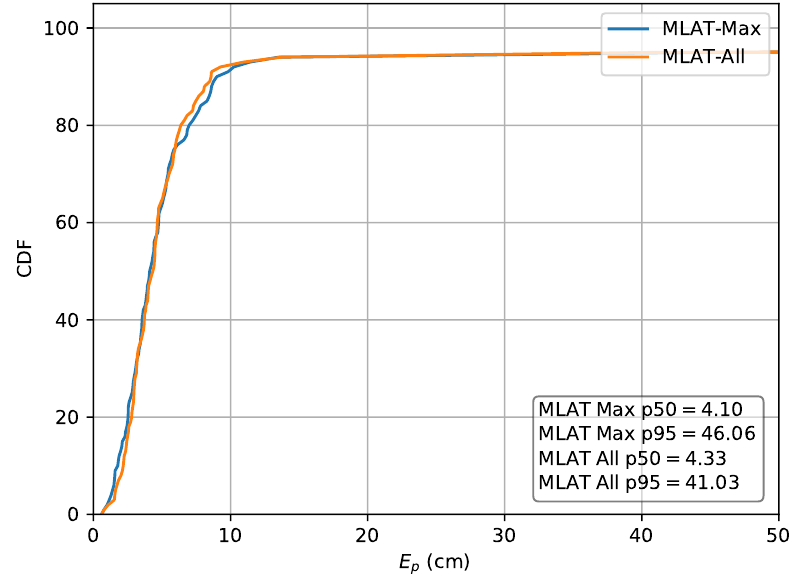
Figure 14. Cumulative distribution of the error evaluated on set A for the relative multilateration schemes using r rel , max and r rel , all